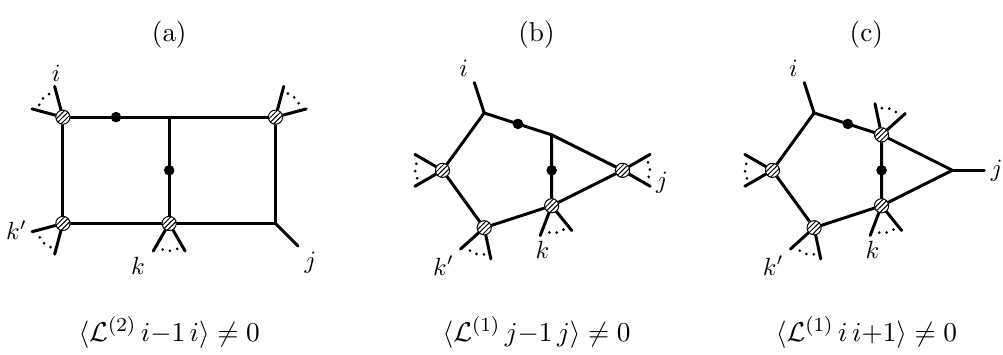
Figure 3 . These are the unique single-relaxations of table 2(a) that result in NMHV Landau diagrams. The computation of the associated Landau singularities is discussed in the text.